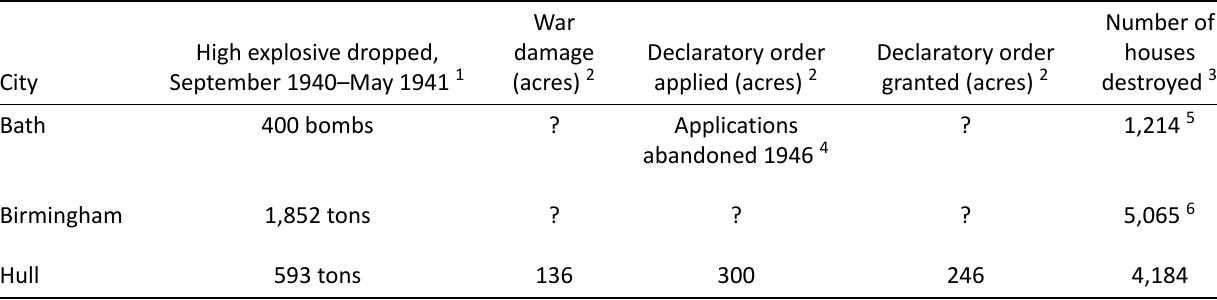
Table 1. Wartime damage